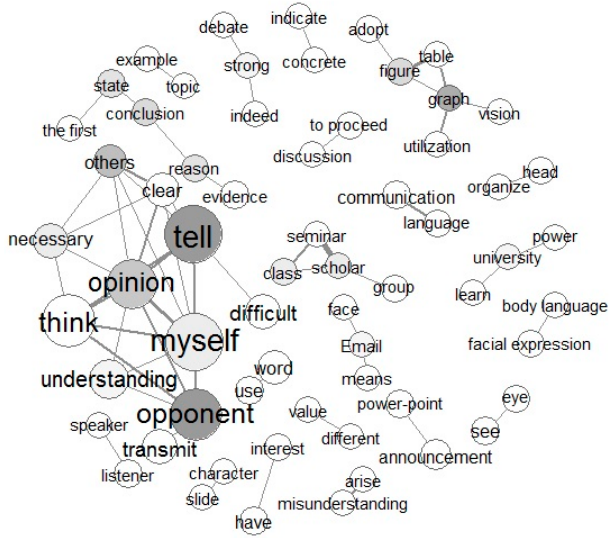
Figure 2. Co-occurrence words network of Task 2 responses to “What do you need to do in order to convey your thoughts and opinions to others?” and “What is difficult when you tell others about an issue?”.